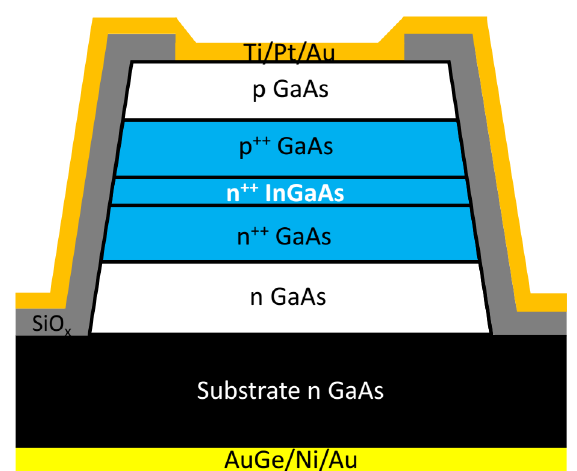
Figure 3. Schematic illustration of the tunnel-junction device structure.